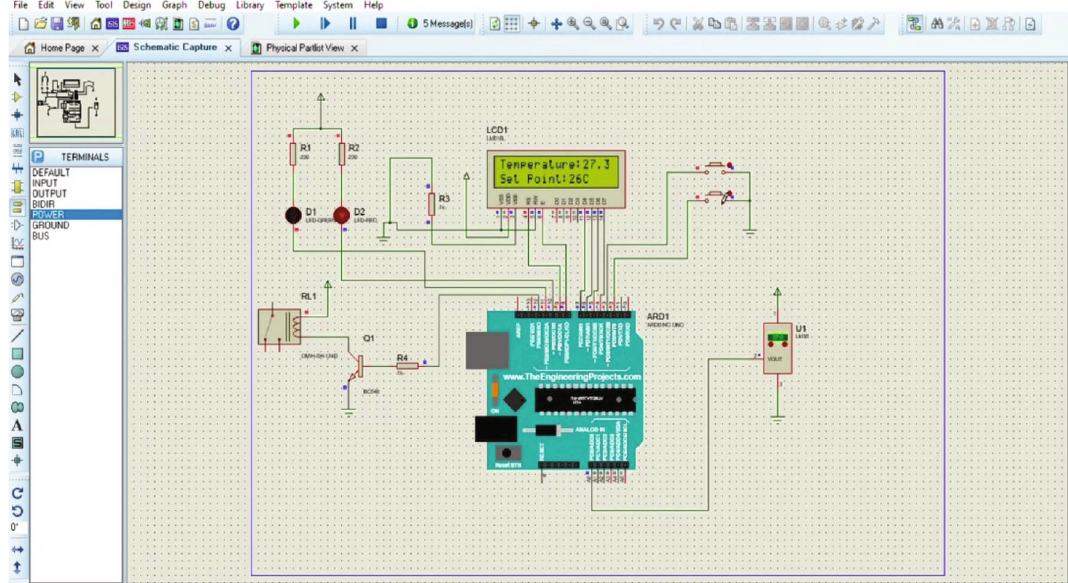
Figure 6: Heater is in o ff state as the temperature exceeds the set point.